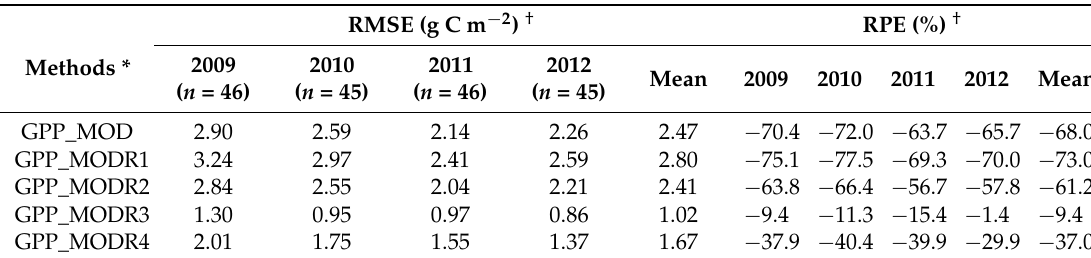
Table 3. Performances of MODIS-based GPP estimations methods on daily GPP estimations as compared to the insitu flux tower GPP